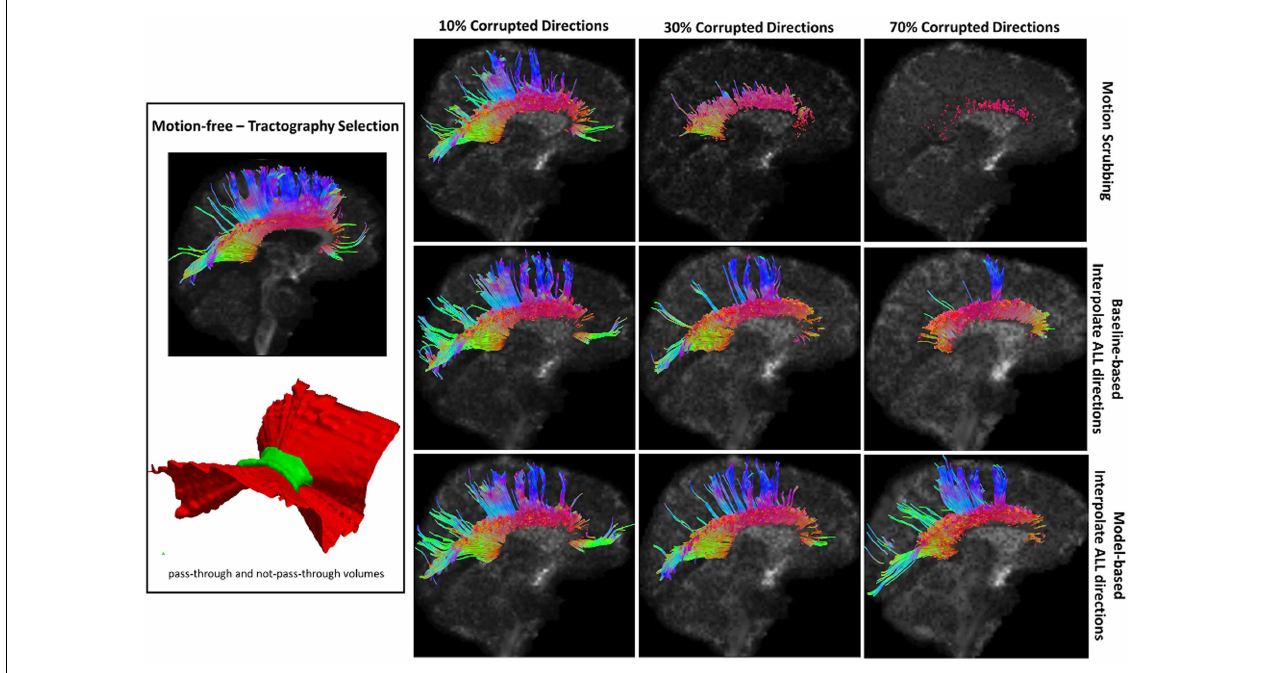
scrubbing) and registration-based (using baseline and model-based reference volumes). One can observe the short tracts being detected by motion scrubbing at high corruption percentages due to the exclusion of too many gradient directions.